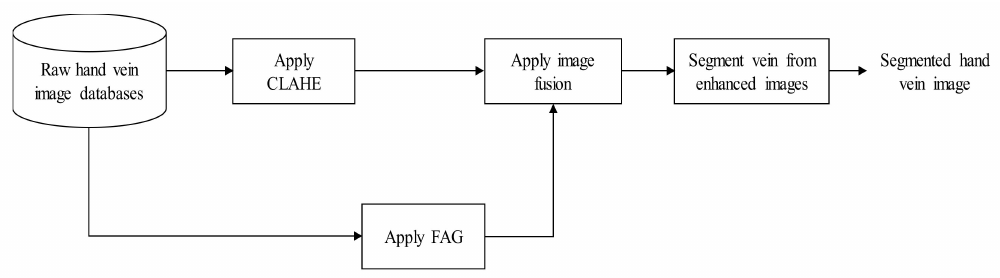
Figure 1. Block diagram of the proposed fusion of CLAHE and FAG for hand vein image